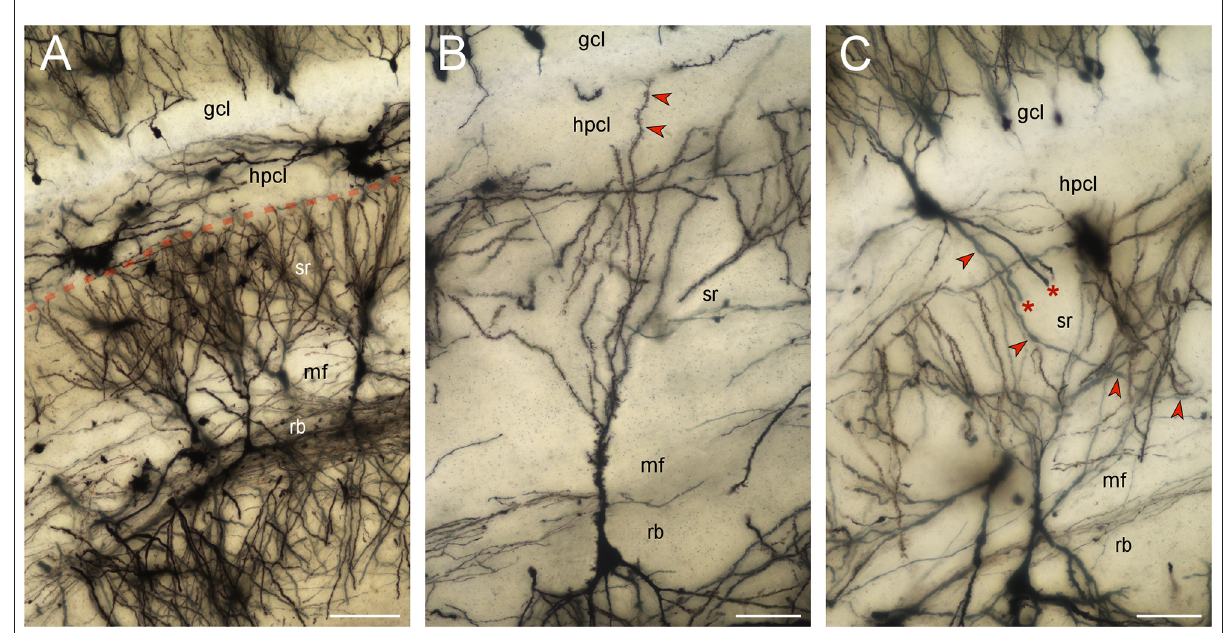
FIGURE5 Golgi-stained reflected blade. Minimum density projections of image stacks. Out-of-focus elements of some planes were removed before the stacks were merged. (A) The vast majority of the apical dendrites of pyramidal cells located in the reflected blade (rb) respect the boundary (red stippled line) between the hilar polymorphic cell layer (hplc) and the extension of the CA3 stratum radiatum (sr) beneath the suprapyramidal blades of the granule cell layer (gcl) and hilar polymorphic cell layer (hplc). Scalebar: 100 µ m. (B) A rare pyramidal cell extending one of its apical dendrites (red arrow heads) into the hilar polymorphic cell layer (hplc). The dendrite stops at the base of the granule cell layer (gcl). Scalebar: 50 µ m. (C) A likely inhibitory interneuron with smooth or beaded dendrites extends an apical tuft of dendrites into the granule cell layer (gcl) and three large basal dendrites into the stratum radiatum (sr). Two of the basal dendrites are truncated (asterisk). The third one (red arrowheads) can be followed to the mossy fiber zone (mf). Scalebar: 50 µ